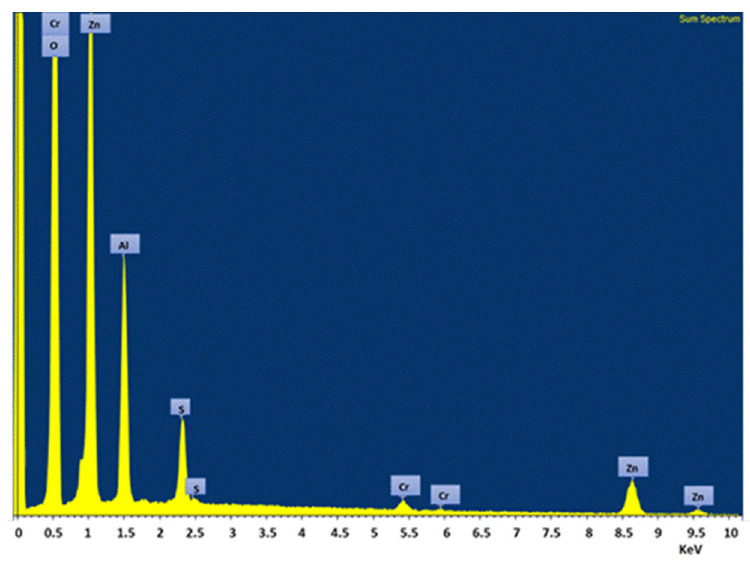
Figure 6. EDS spectrum of elements present in ZnAl-SO 4 LDH substrate after adsorption of ions from wastewater.